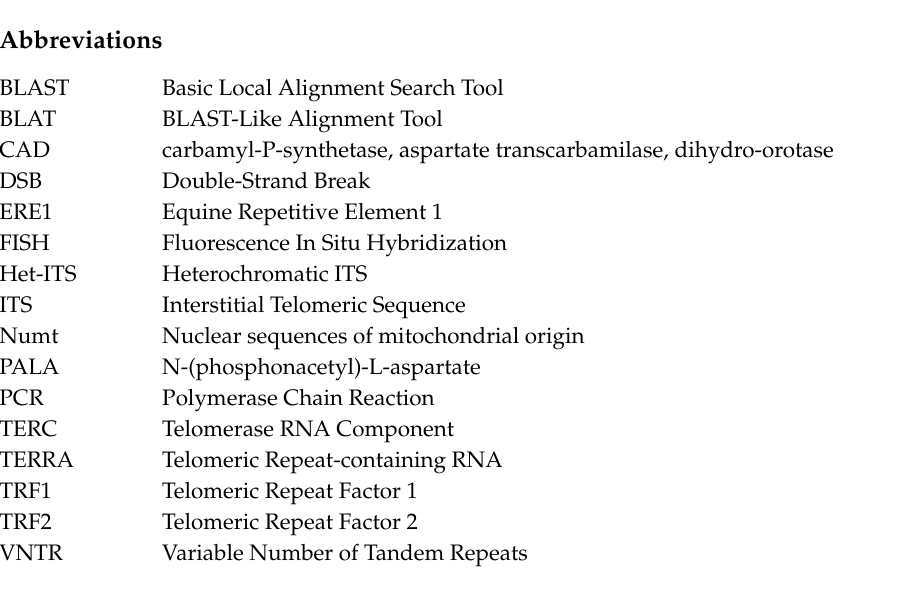
Supplementary Table S1. List of human ITS loci ranked by coordinate; Supplementary Table S2. Primer pairs used to PCR-amplify human-specific ITS loci; Supplementary Table S3. List of horse ITS loci ranked by coordinate; Supplementary Table S4. Primer pairs used to PCR amplify horse ITS loci; Supplementary Table S5. Chromosomal distribution of human ITS loci; Supplementary Table S6. Chromosomal distribution of horse ITS loci; Supplementary Figure S1. Search of ITS-less alleles in